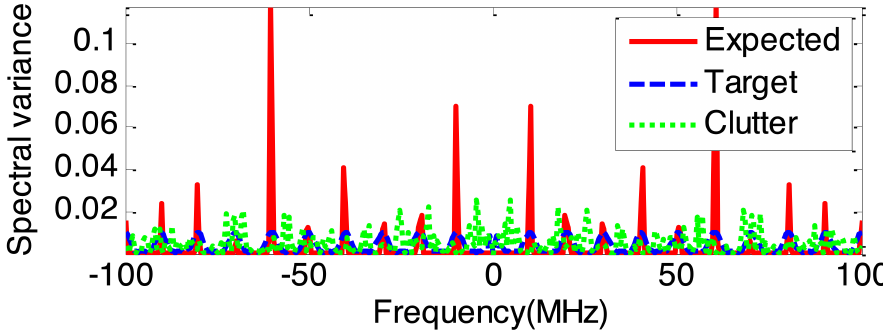
Figure 4. The spectral variance of the expected optimum waveform, target and sea